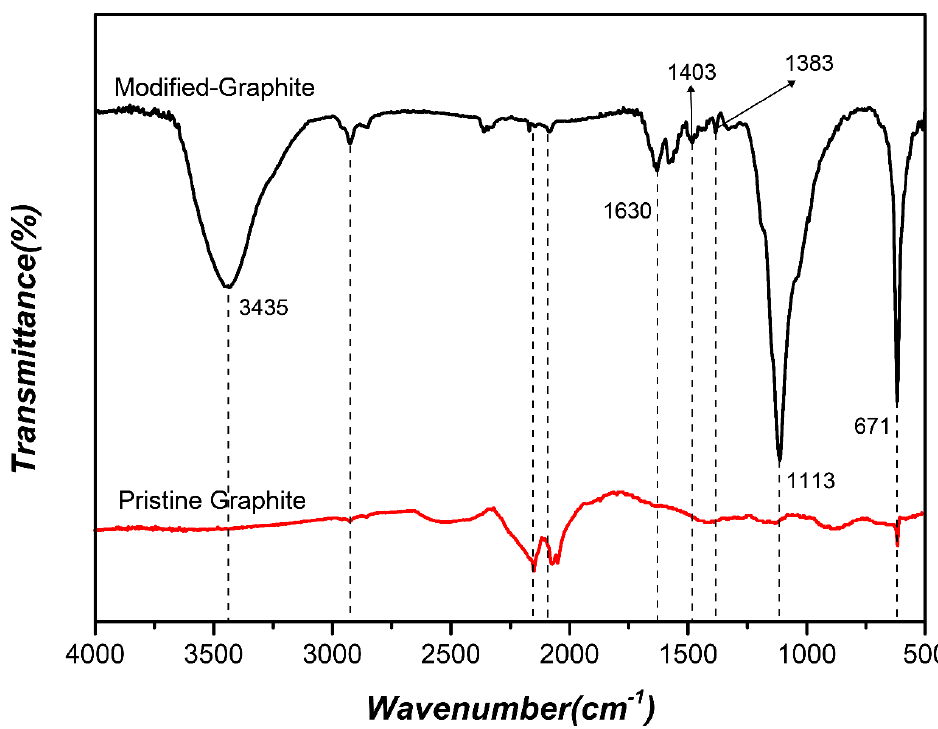
Figure 2. Fourier Transform Infrared (FTIR) spectra of pristine graphite and modified graphite. Table 3. Average Diameters of Graphite Sheets (nm).